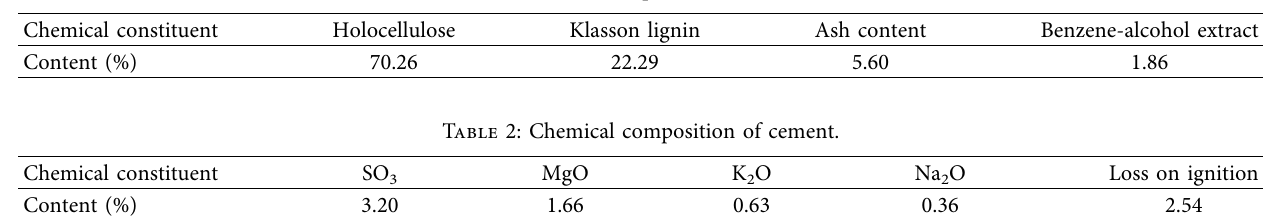
Figure 1: SEM comparison of PL before and after anticorrosion treatment: (a) before, (b) during, and (c) after. Table 1: Main chemical components of cotton stalk fiber.